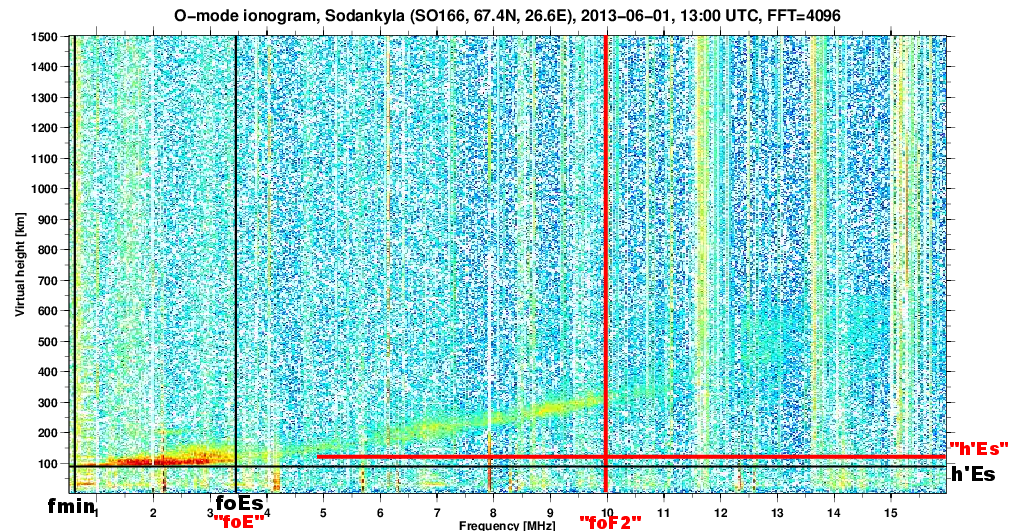
Figure 6. Differences between manual and Autoscala scaling arising from high latitude sporadic E phenomena. Black lines show manually scaled parameters, and red colour (lines and/or letter) indicates Autoscala results. Example 1: foE s identified as foE, and the slant E s (type S) identified as an F layer.